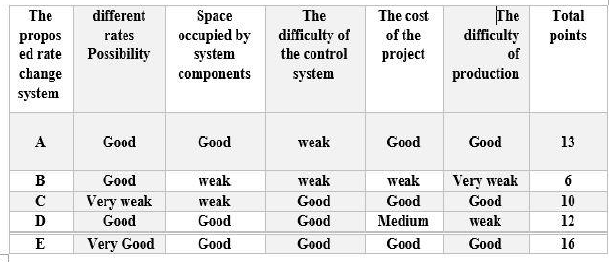
Figure 6 - Changing the rotational speed of seed metering drive shaft using the solar gearbox